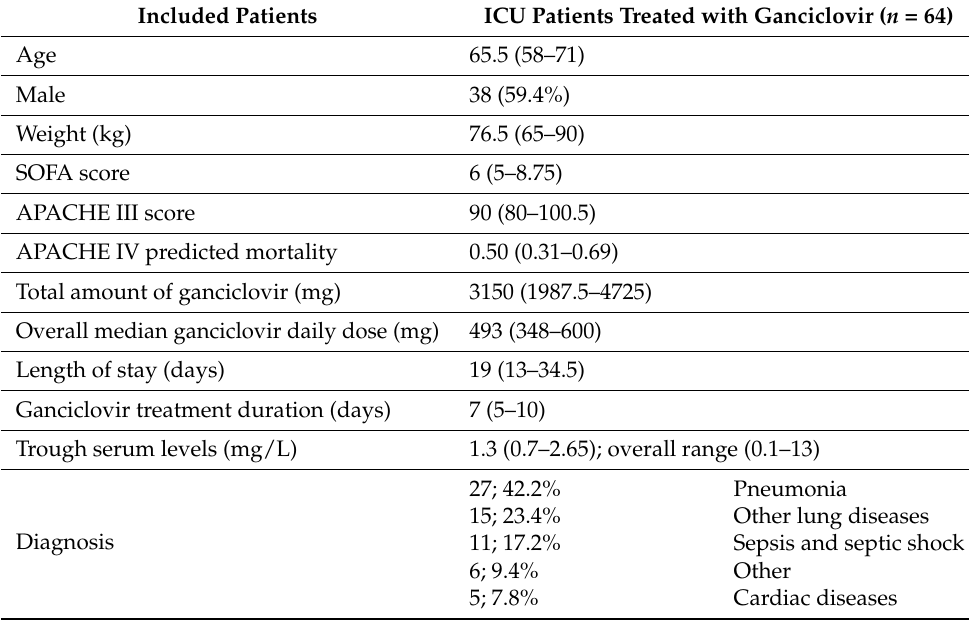
Table 3. Baseline characteristics: data shown as median (IQR) or number and percentage.